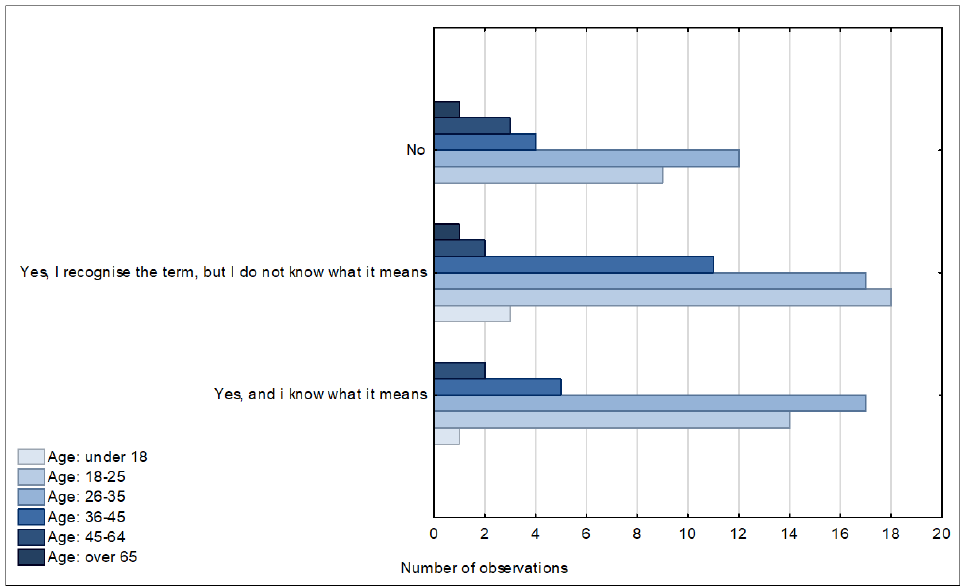
Figure 9. Awareness of the term “ smart city ” in different age groups. Source: own study based on questionnaire surveys.